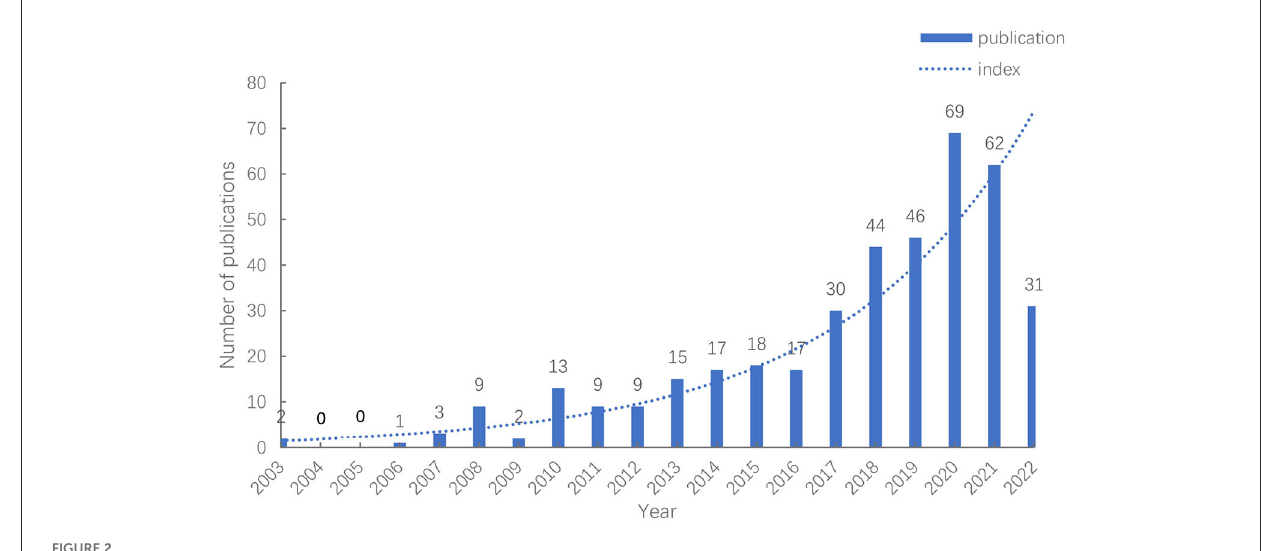
FIGURE2 Publication trends over time.